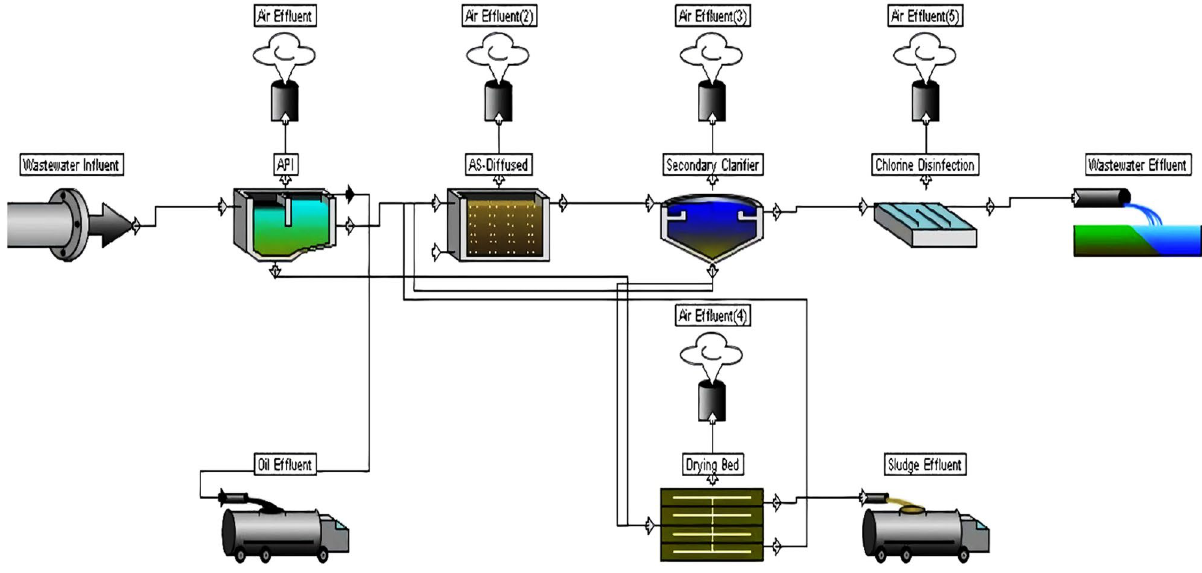
Figure 1. Schematic diagram of EEAS system in